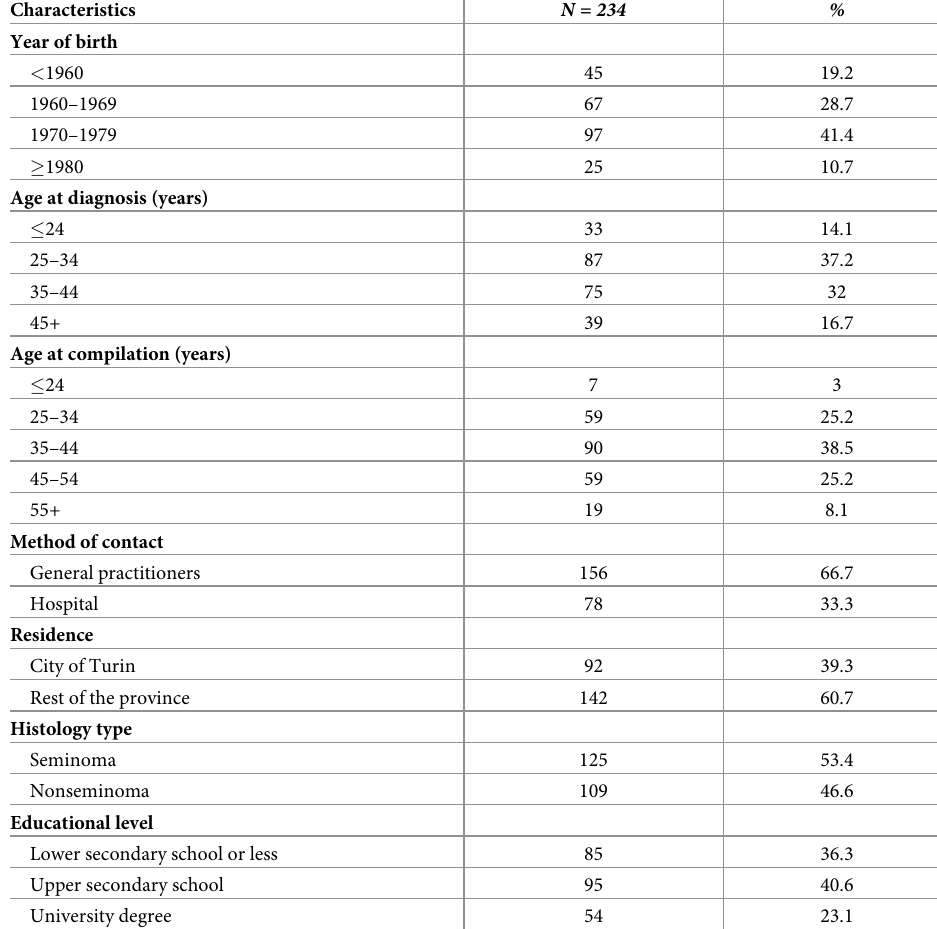
Table 1. Descriptive characteristics of the cases included into the